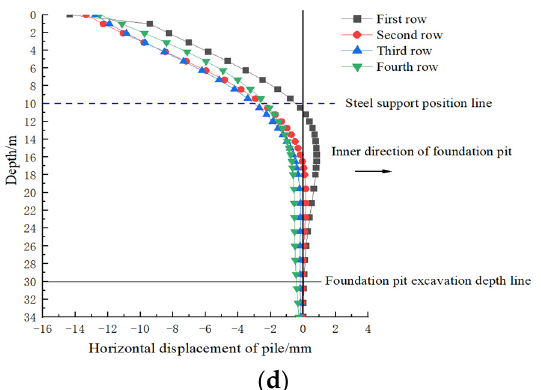
Figure 24. Stress analysis of the sectionalized support system (arrangement of sparse-dense pile and tie-beam). ( a ) schematic diagram of the support model of sparse-dense pile and tie beam (Unit: m); ( b ) displacement of retaining pile body; ( c ) displacement of pile body at reinforced point (bedding rock side); ( d ) displacement of pile body at the reinforced point (toppling rock side).